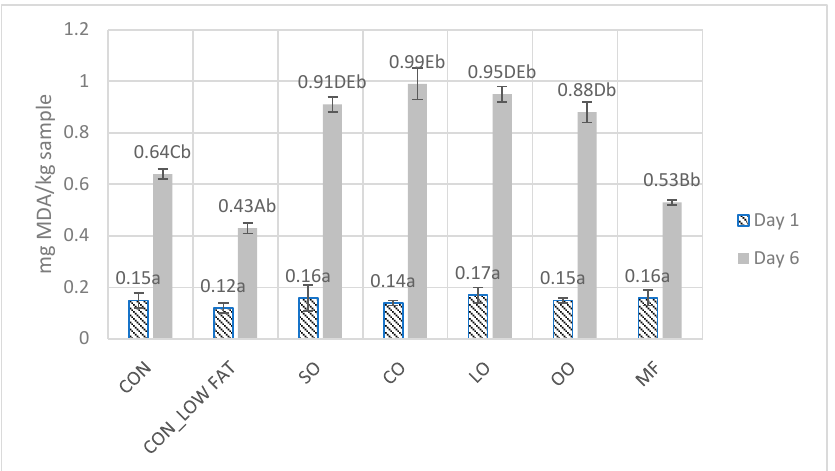
Figure 1. The lipid oxidation degree in burgers on the 1st and 6th day of storage measured by TBARS method. CON—control group beef burgers, CON_LOW FAT—burgers with reduced fat, burgers with fat substitutions, i.e., sunflower oil (SO), canola oil (CO), linseed (LO), olive oil (OO) and milk fat (MF). (A–E)—means with different letters showing significant effect of treatment group in the same day of storage; a, b—means with different letters showing significant effect of storage time in each treatment group; p ≤ 0.05.